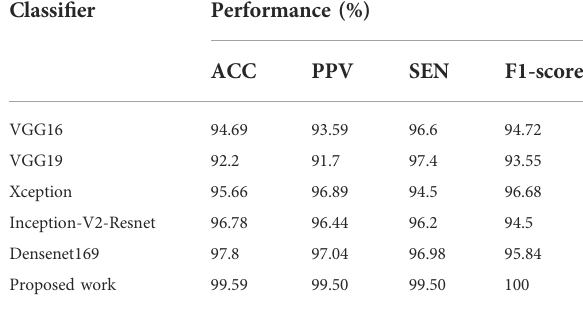
TABLE 3 Experimental results obtained with proposed model and different DL models on CT scan images. Classi fi er